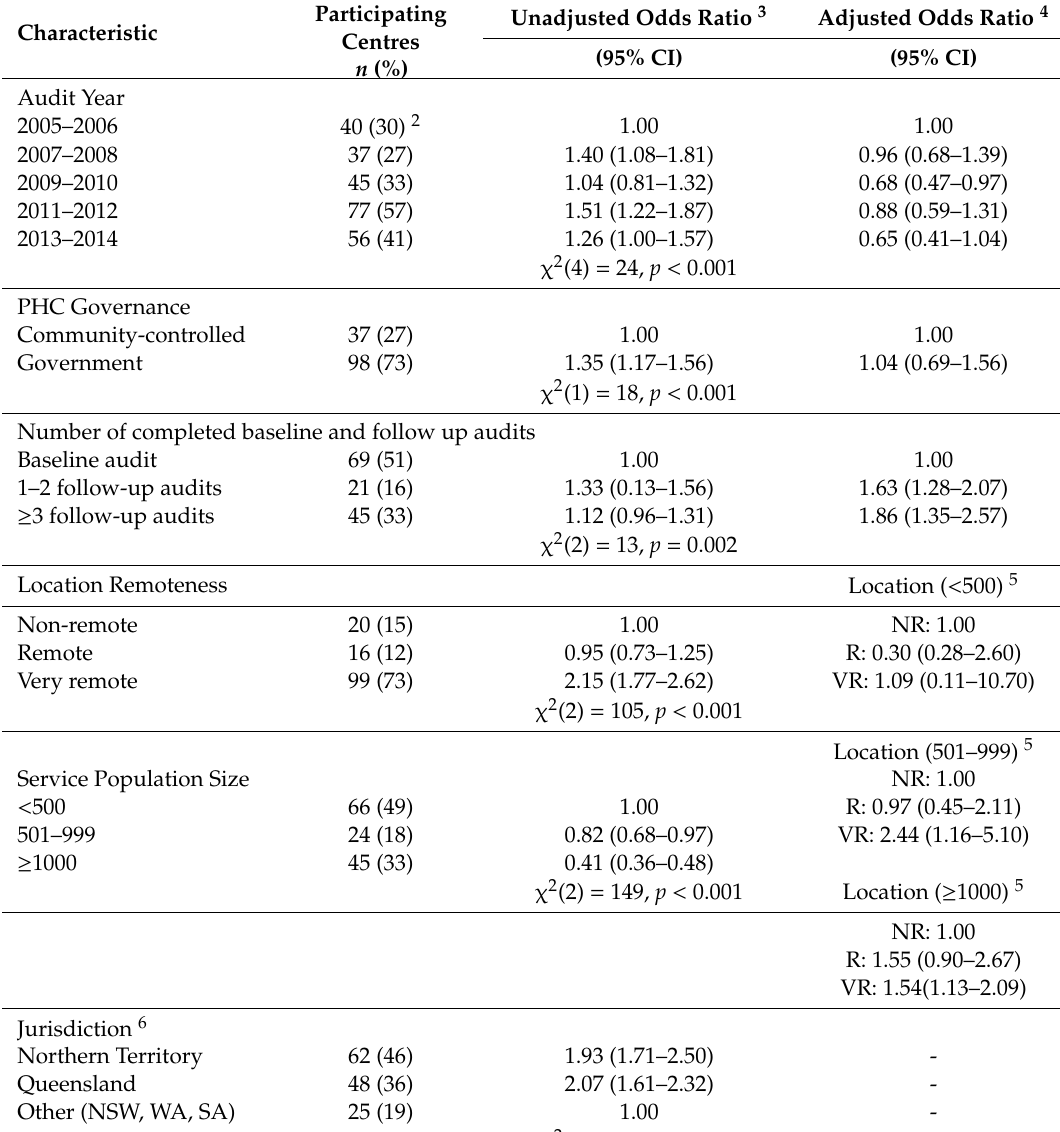
Table 1. Associations between Indigenous primary health care centre ( n = 135) characteristics and cervical screening among female clients ( n = 3801) 1